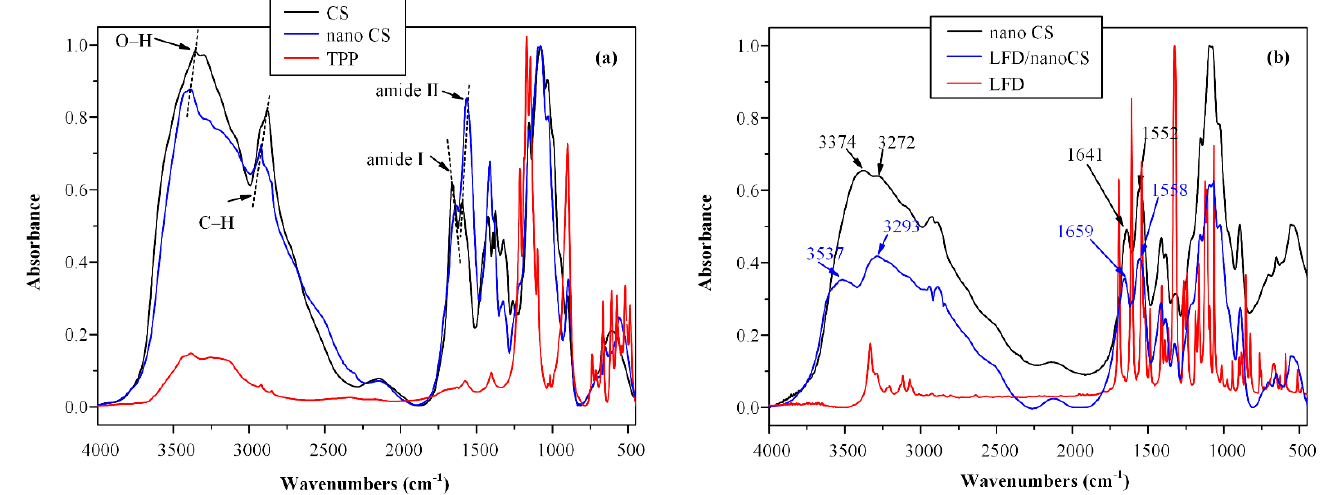
Figure 2. FTIR spectra of: ( a ) neat CS, neat triphenyl phosphate (TPP) and neat CS NPs (nano CS), and ( b ) neat LFD, neat CS and LFD-loaded CS NPs (LFD/nano CS).